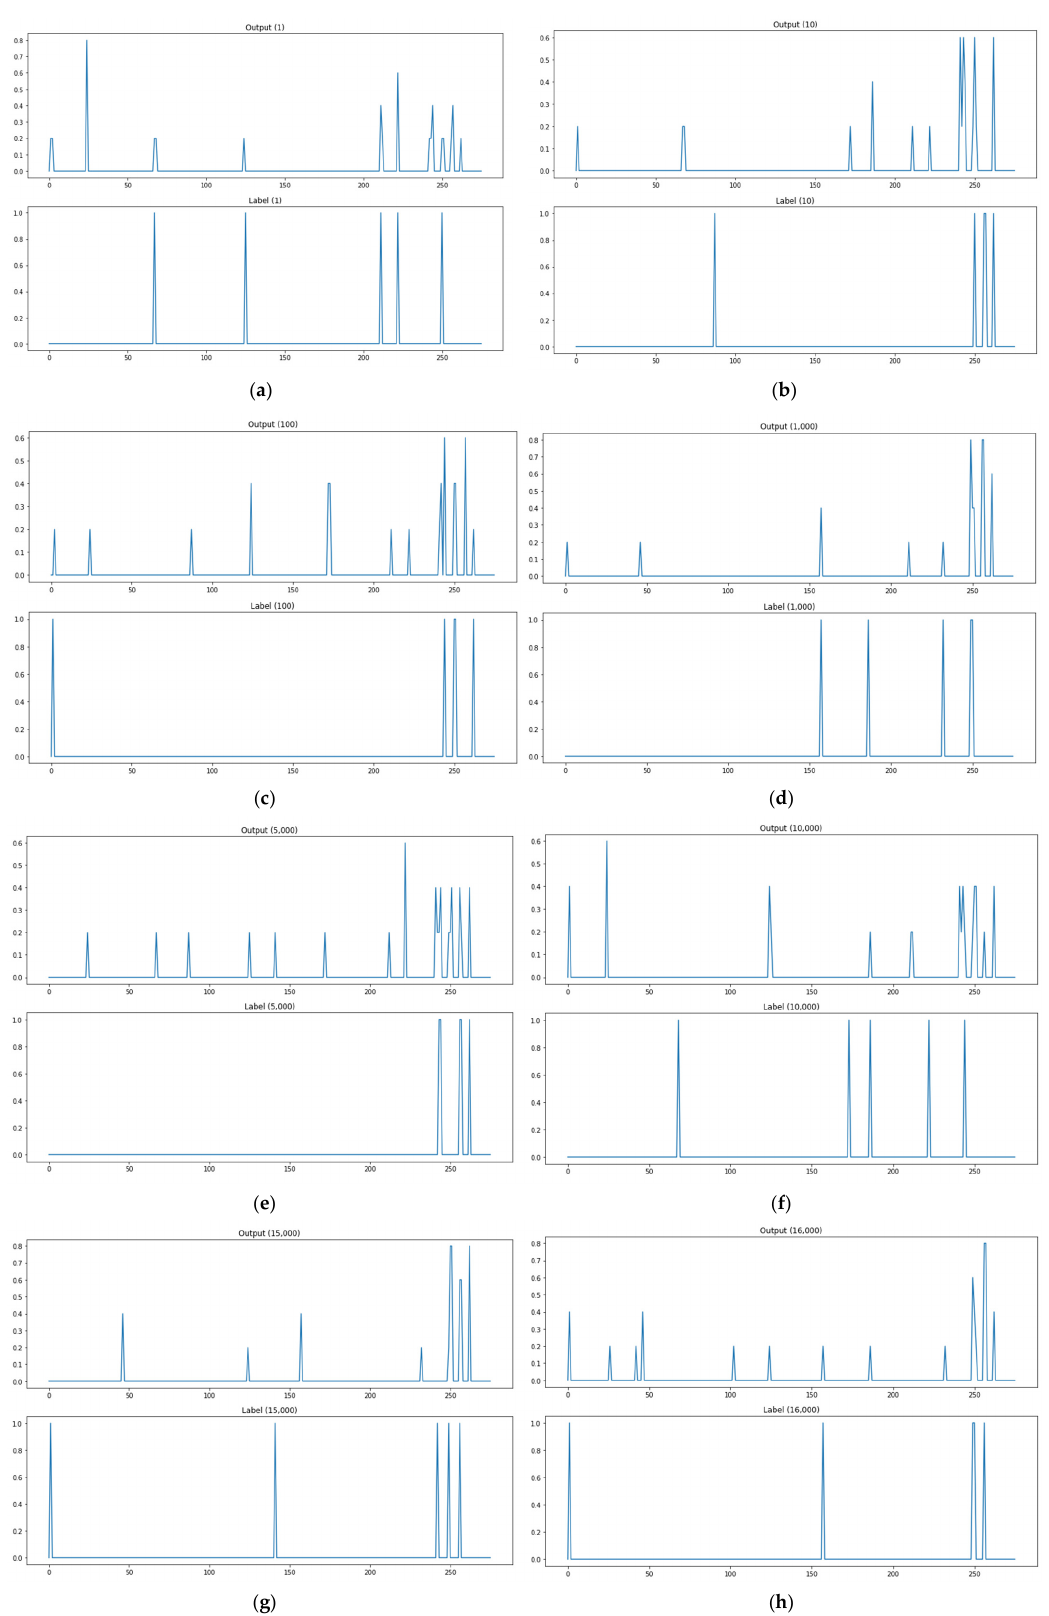
Figure 11. The outputs of algorithm adaptation method based on kNN regression. ( a ) Test data 1. ( b ) Test data 10. ( c ) Path test data 100. ( d ) Path test data 1000. ( e ) Path test data 5000. ( f ) Path test